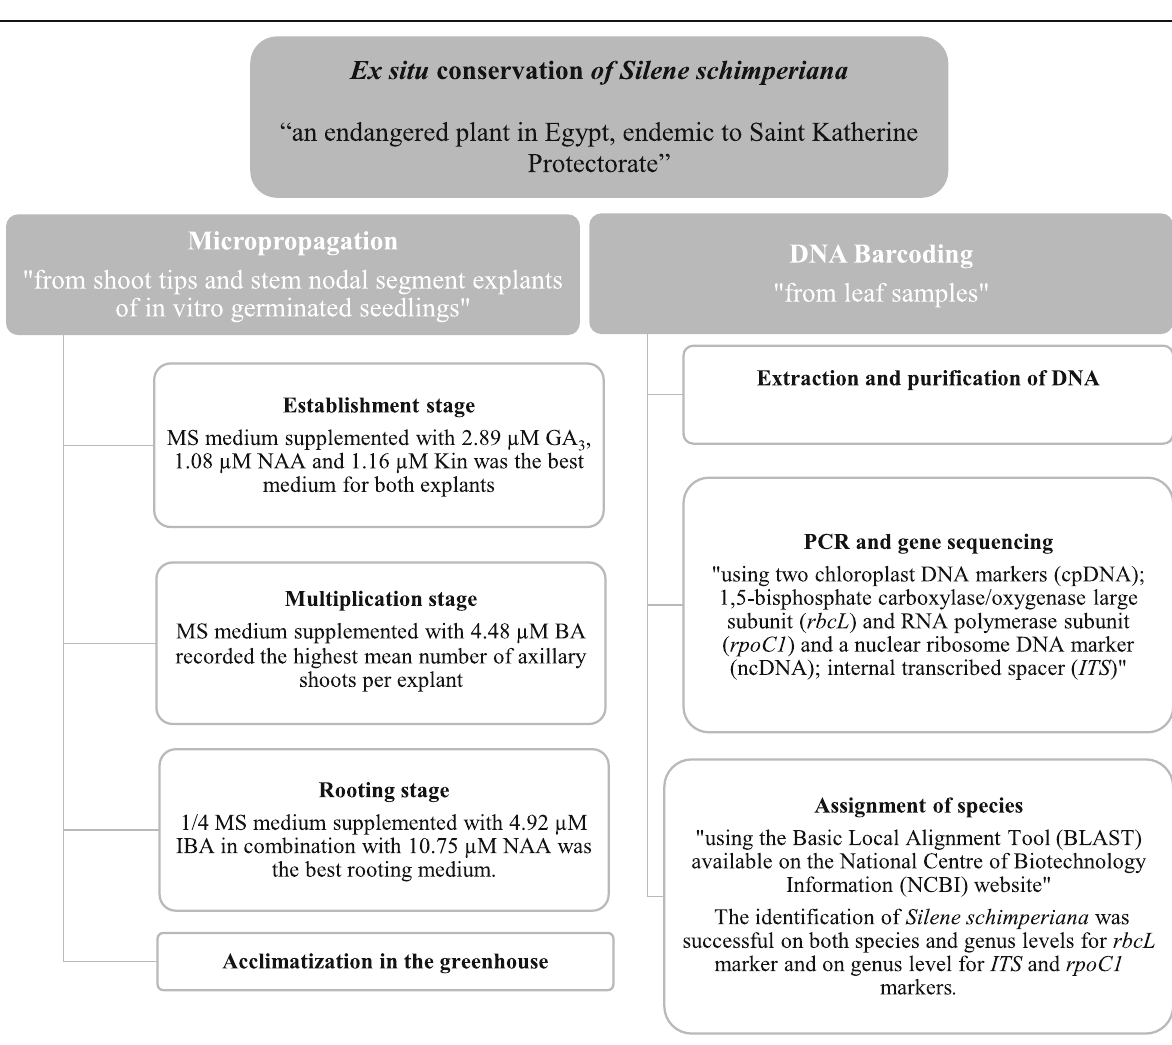
Fig. 8 A schematic diagram of the ex situ conservation program done in the present study for Silene